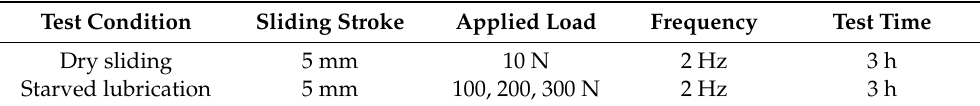
Table 3. Experimental